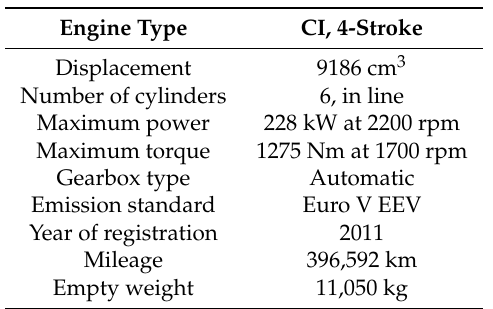
Table 3. A 12 m diesel bus matching the Euro V EEV emission standard is tested under actual vehicle operating conditions. This bus has SCR and DPF aftertreatment systems reducing NOx and particulate matter emissions,